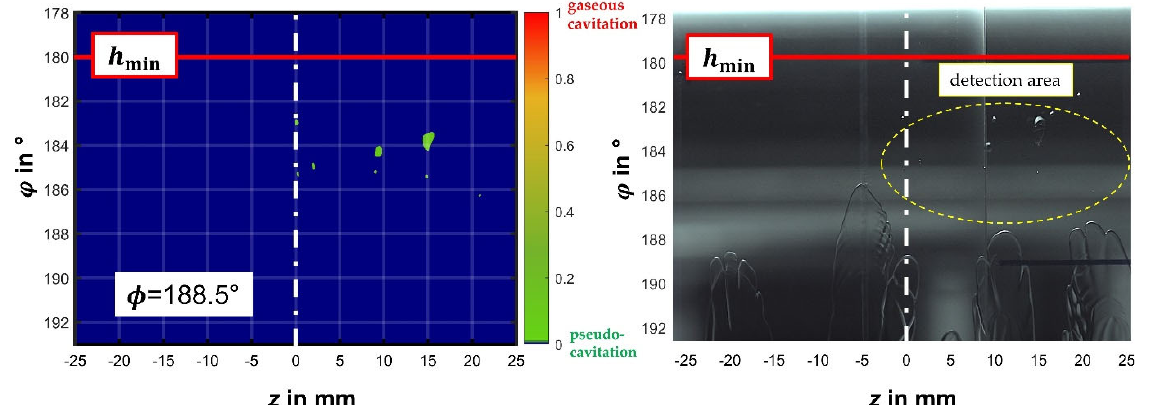
Figure 15. Bubbles decreasing in size by solely pseudo-cavitation, rotational angle φ = 188.5 ◦ after initiation of transient radial displacement, fluid: paraffin containing 100% dissolved air.